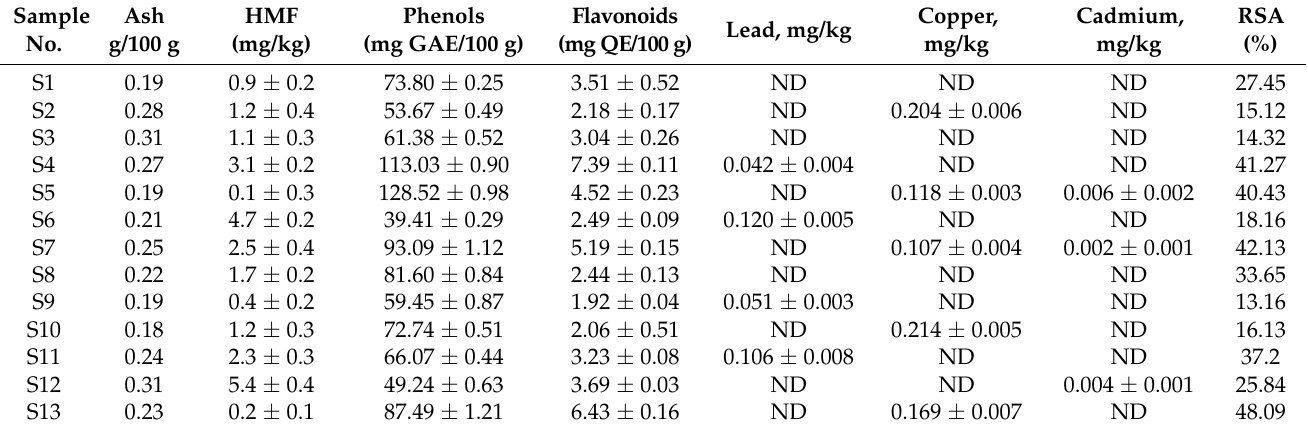
Table 3. The chemical parameters of the honey samples from North-West and Central of Romania.